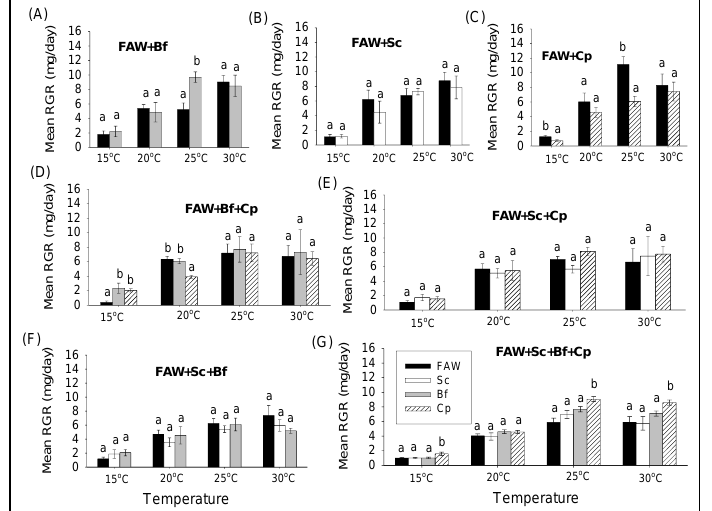
Figure 4. Comparison of relative growth rates of S. frugiperda (FAW), B. fusca (Bf), S. calamistis (Sc), and C. partellus (Cp) in multi-species combinations at different constant temperatures. Means (±SE) with different letters are significantly different, determined using False Discovery Rate (FDR) [22] with lsmeans R package [21], following analysis of variance (ANOVA) after constructing general linear models. A = FAW + Bf, B = FAW + Sc, C = FAW + Cp, D = FAW + Bf + Cp, E = FAW + Sc + Cp, F = FAW + Sc + Bf, G = FAW + Sc + Bf +